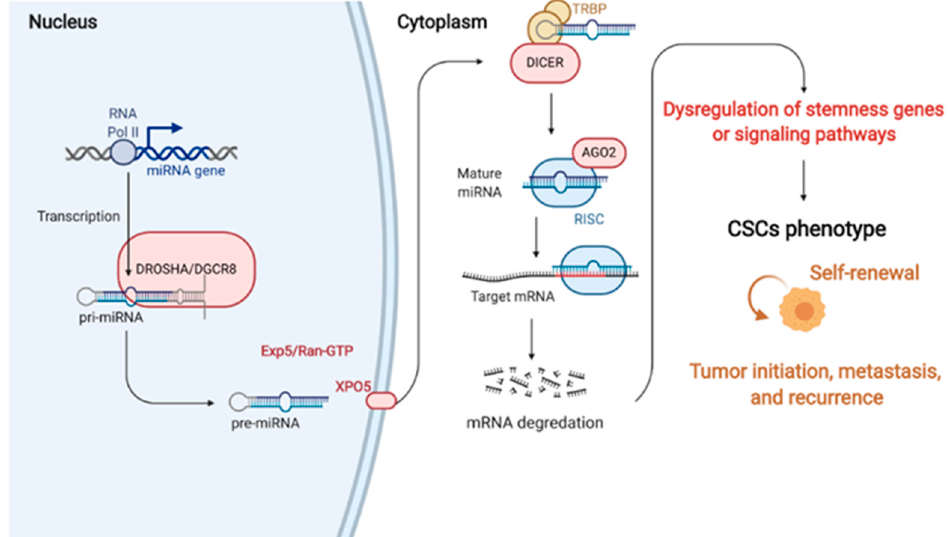
Figure 1. The generations and roles of miRNAs in cancer stem cell (CSC) regulation. In miRNA generation, miRNA genes are commonly transcribed by RNA Pol II in the nucleus. This transcription, which is cleaved by Drosha, produces a multiprotein complex with the DGCR8 protein. Cleavage induces pre-miRNA binding to the nuclear export factor EXO5 and then transported from the nucleus to the cytoplasm. In the cytoplasm, Dicer (another RNase III), which forms a complex with the double-stranded RNA-binding protein TRBP, cuts out the hairpin and produces an RNA duplex with approximately 22 nucleotides. The RNA duplex is dissociated to a single strand via AGO2 mediation, incorporated into the RISC, and binds to 3 (cid:48) UTR of the target mRNA to suppress the gene expression. Therefore, miRNAs can regulate cancer stemness properties and phenotypes by targeting the critical genes that control the activation of signaling pathways, transcriptional factors, and secreted factors. RNA Pol II, RNA polymerase II; pri-miRNAs, primary miRNAs; pre-miRNAs, precursor miRNAs; EXO5, exportin 5; AGO2, argonaute 2; RISC, miRNA-induced silencing complex; mRNA, messenger RNA; miRNA, microRNA (created with Biorender.com (accessed on 30 January